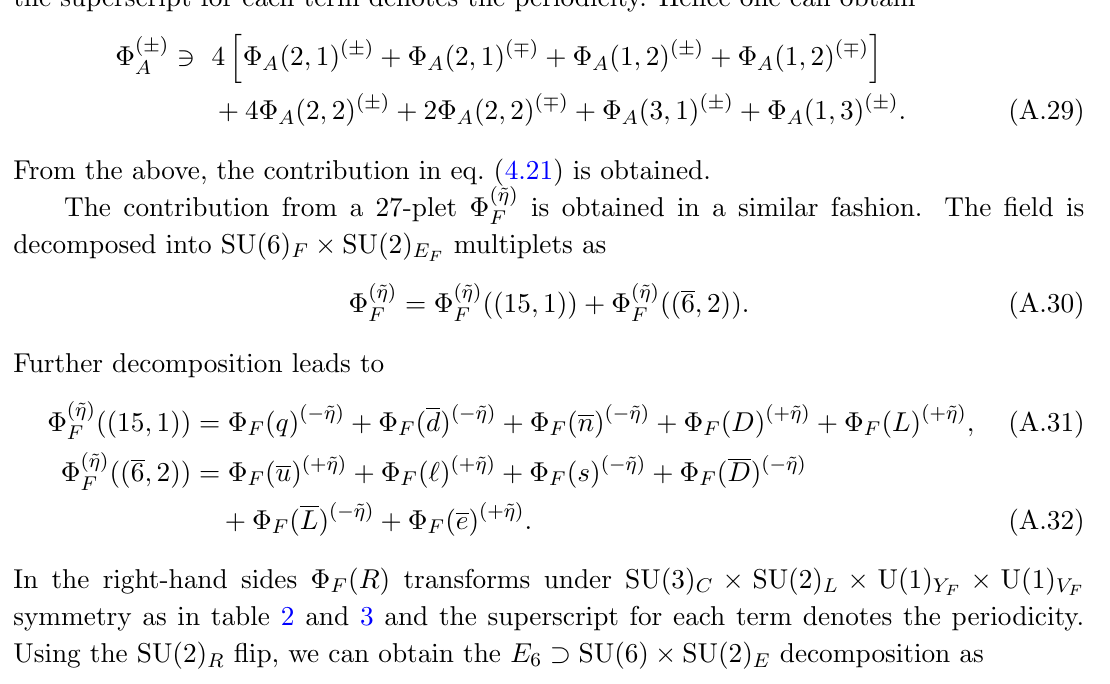
( R; R 0 ) transforms under SU(2) A